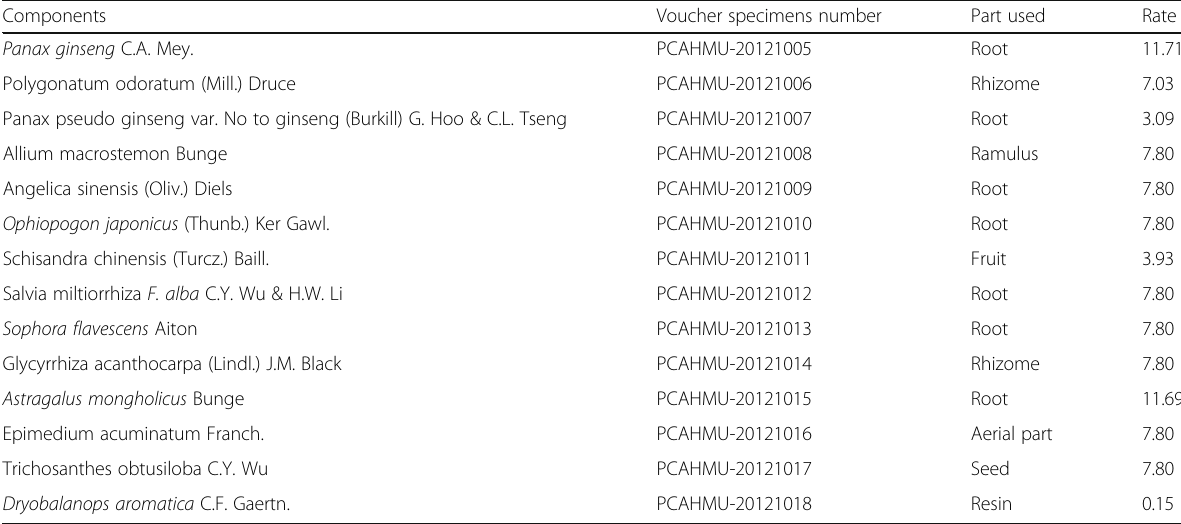
Table 1 Recipe of XJEK